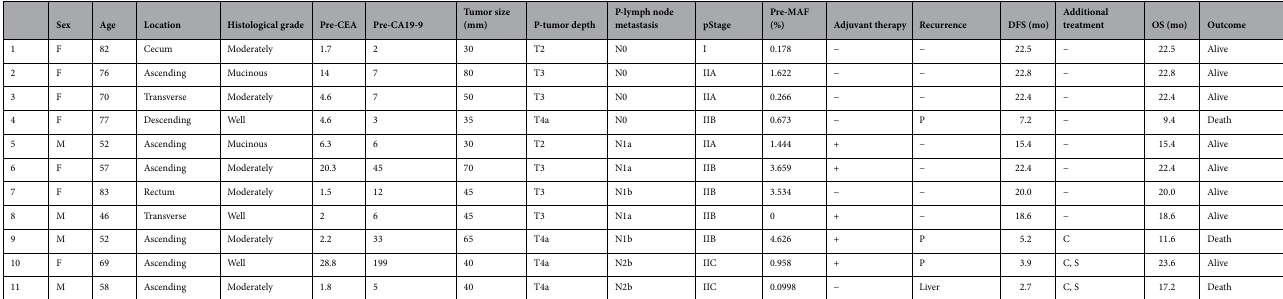
Table 2. Progress of the patients’ treatment. DFS disease-free survival, OS overall survival, P peritoneal dissemination, C chemotherapy, S